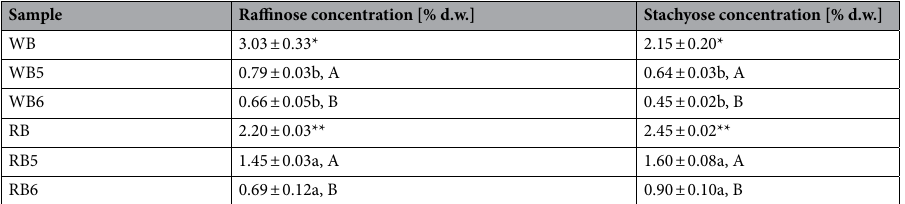
Table 2. Concentration of stachyose and raffinose in bean seeds and bean malts. Data are shown as means ± standard deviation (n = 4). Various small letters (a, b) indicate homogenous groups according to the variable ‘variety’, various capital (A, B) letters indicate homogenous groups between malts according to the variable ‘days of germination’, various number of asterisks indicate homogenous groups between unmalted seeds according to the variable ‘variety’ (Bonferroni test, α = 0.05). WB white beans, WB5 malt from white bean germinated 5 days, WB6 malt from white bean germinated 6 days, RB red beans, RB5 malt from red bean germinated 5 days, RB6 malt from red bean germinated 6